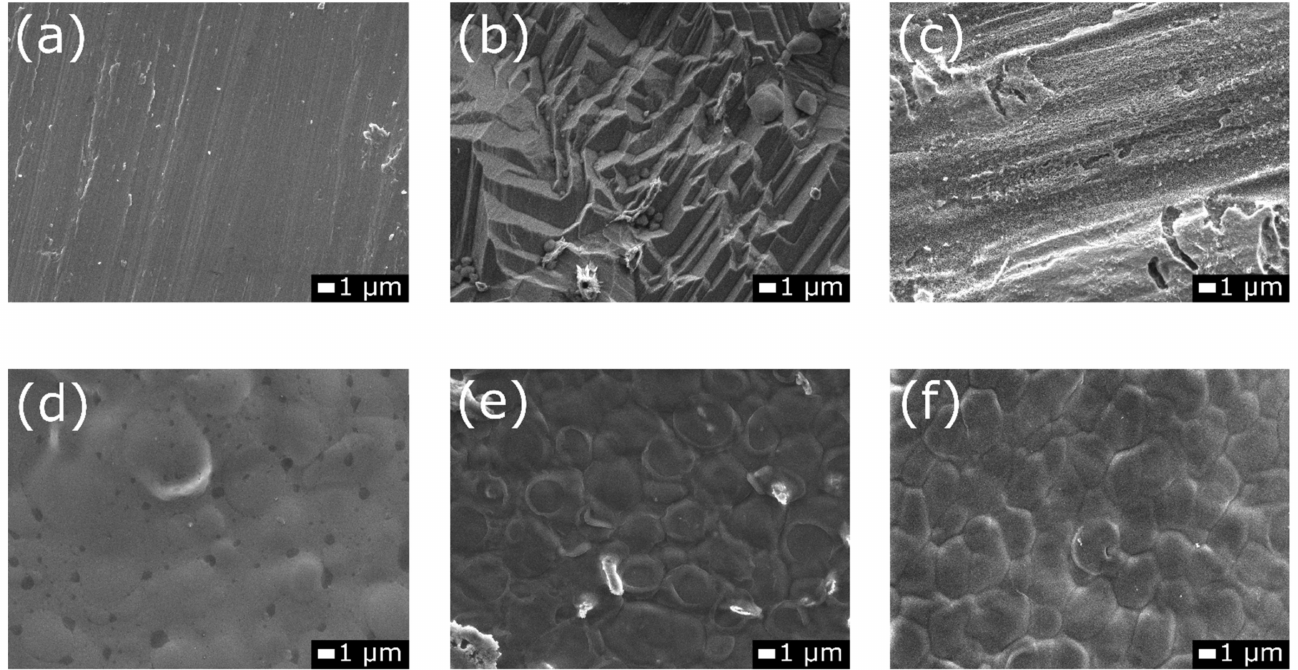
Figure 9. SEM images of the surface of pre-treated Ti grade 2 substrates after ( a ) wet grinding (G), ( b ) acid etching (E), and ( c ) electrochemical anodization (A), and for the samples: ( d ) G1, ( e ) E1, and ( f ) A1 with chit/EE100 coatings after electrochemical tests (images obtained with magnification at ×